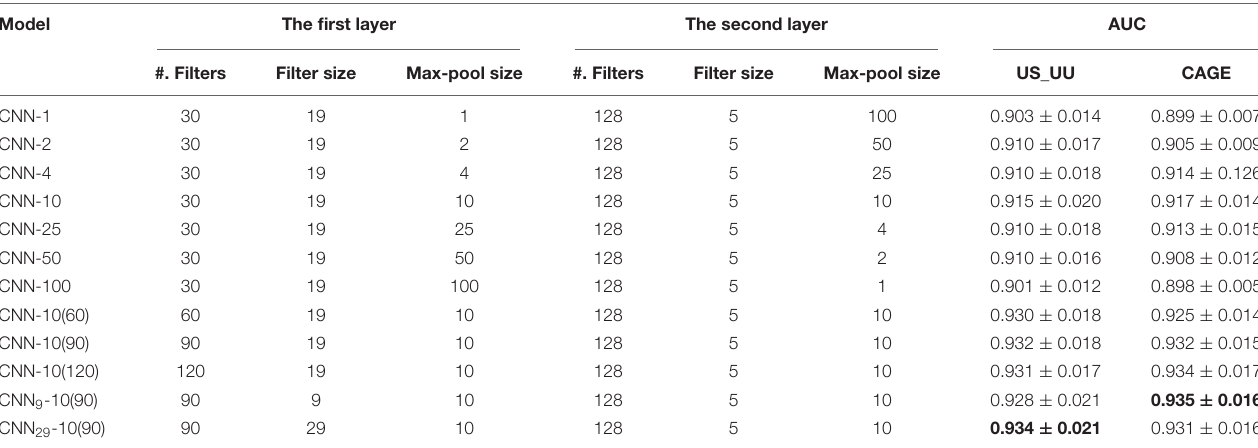
TABLE 2 | Performance of CNN models with different hyperparameters.